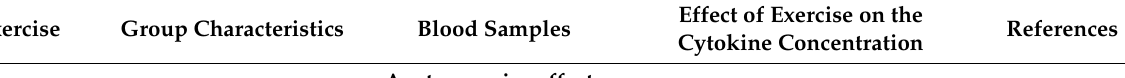
Table 3. Effects of exercise on